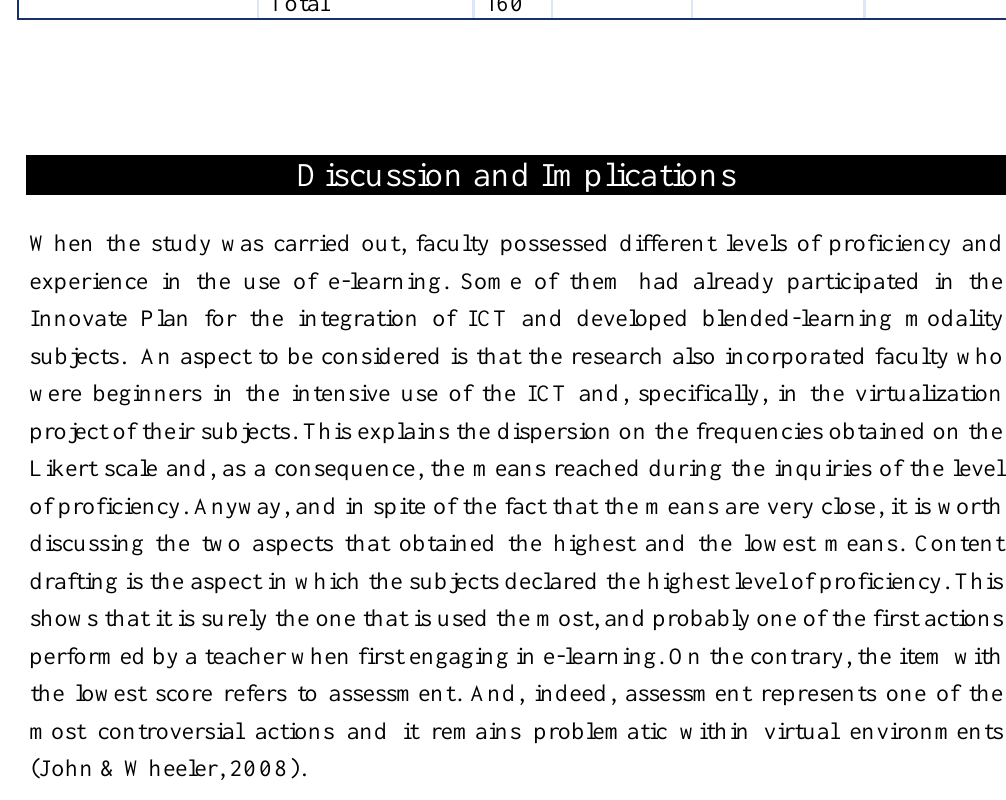
Kruskal-Wallis Test (Variable: “Teaching Experience in Virtual Environments”) Compared variables Level of proficiency in pedagogical